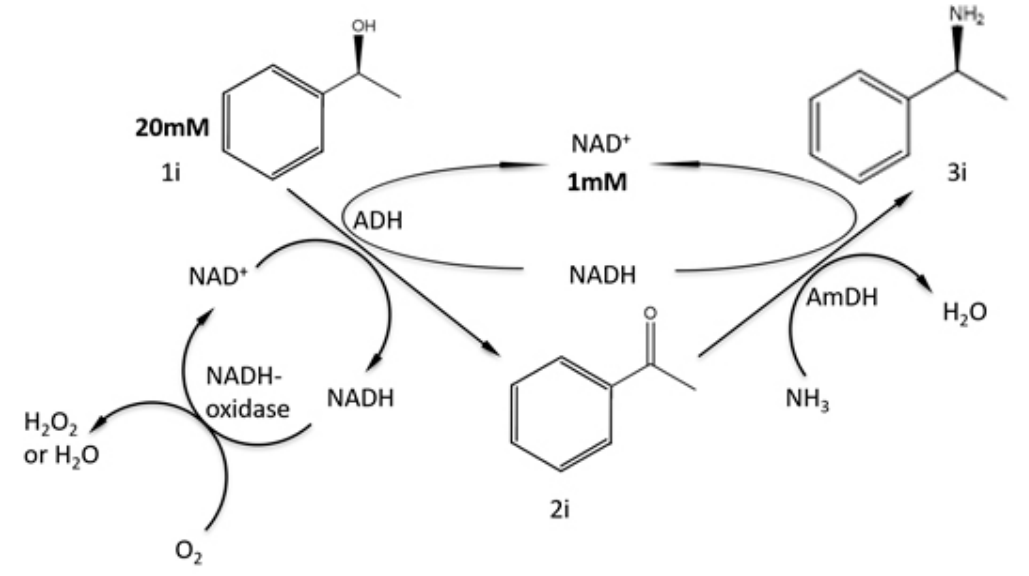
Figure 3. Multi-enzyme catalyzed reductive amination with amine dehydrogenase [9]. Reaction condition: L-Phenylethanol, 20 mM; NH 4 Cl buffer, 2 M (pH 8.7); NAD + 1 mM, 30 °C, 200 rpm, 48 h.